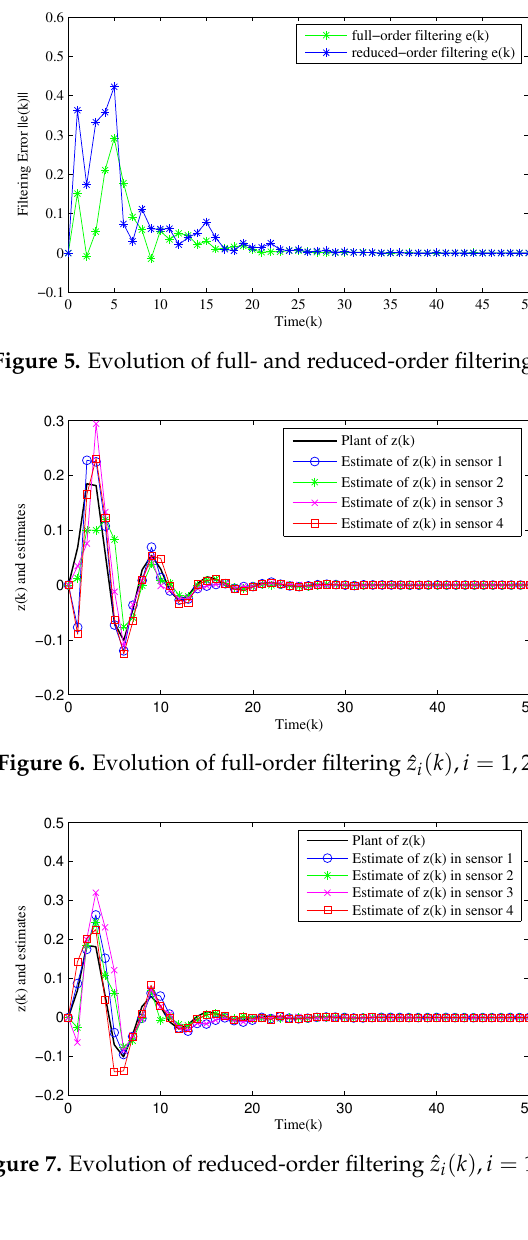
Figure 4. Evolution of attack variable θ i ( k ) , i = 1,2,3,4.